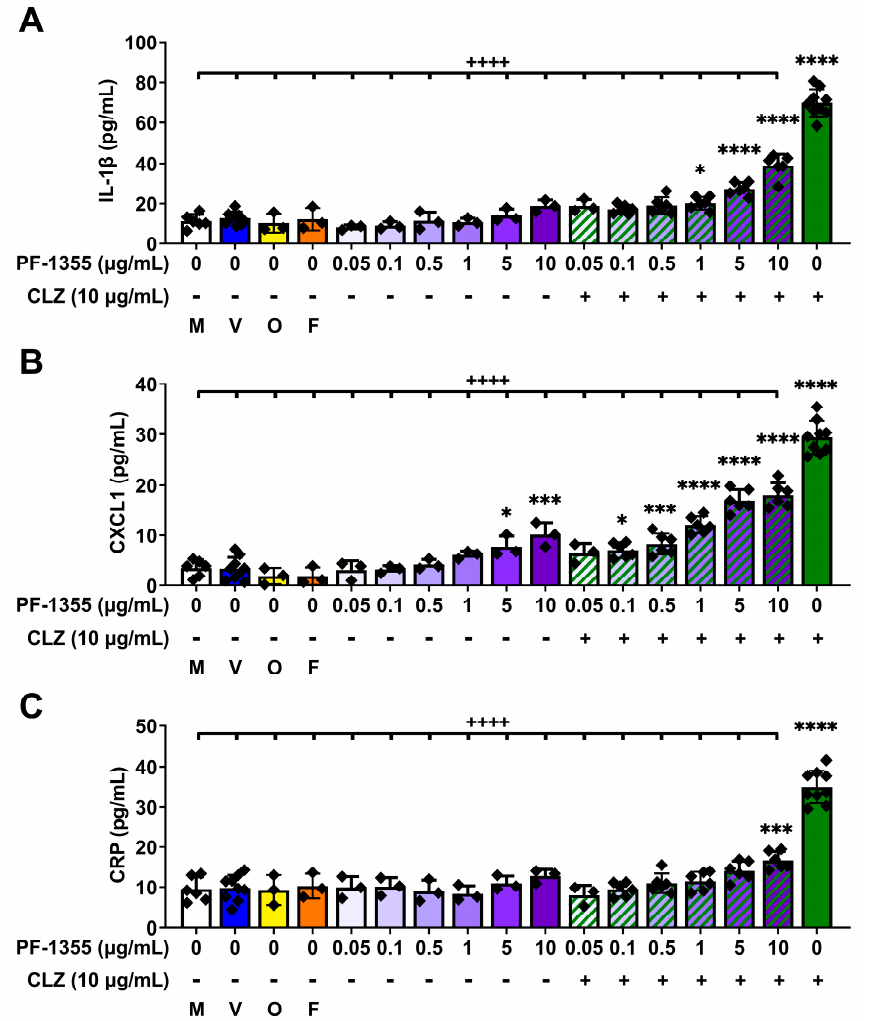
Figure 4. PF-1355 attenuates clozapine-induced increases in inflammatory mediator release in THP- 1 macrophages. ( A – C ) Supernatant concentrations of IL-1 β ( A ), CXCL1 ( B ), or CRP ( C ) in